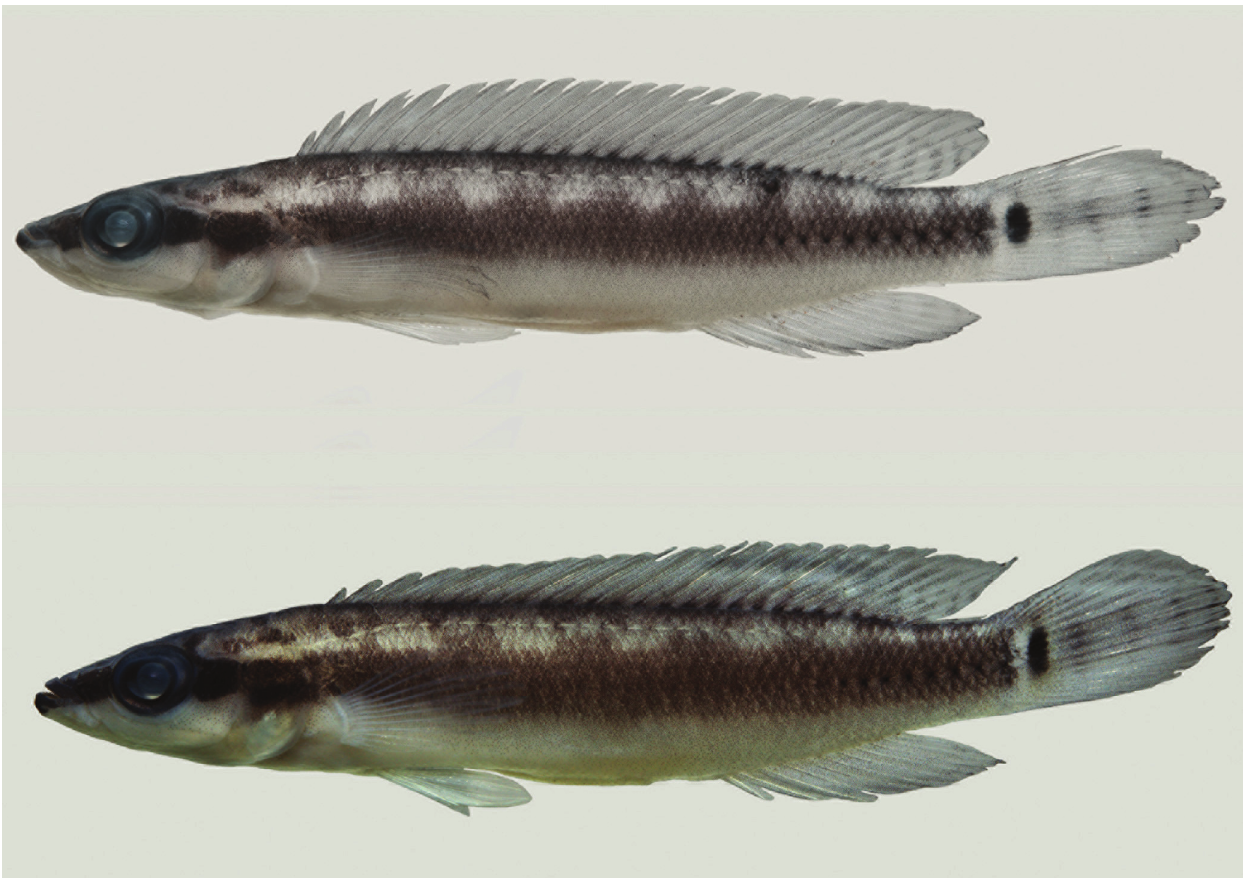
Fig. 1. Crenicichla anamiri , new species, holotype, male, INPA 46650, 42.9 mm SL, Itapuama, below confluence with rio Iriri, State of Pará, rio Xingu (above); paratype, female, INPA 46651, 43.3 mm SL, same locality of holotype (below). Photo by Douglas